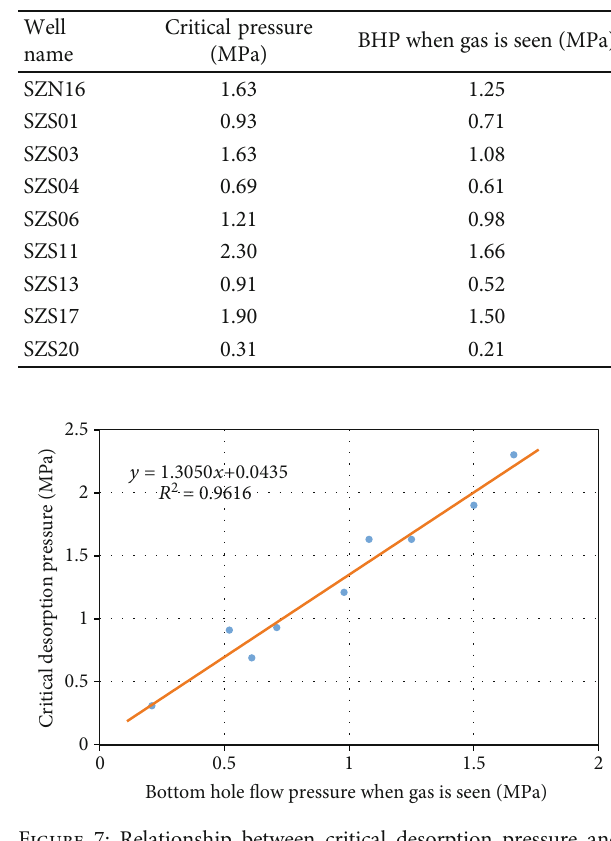
Table 3: Critical desorption pressure and bottom hole pressure at begin of gas fl ow.